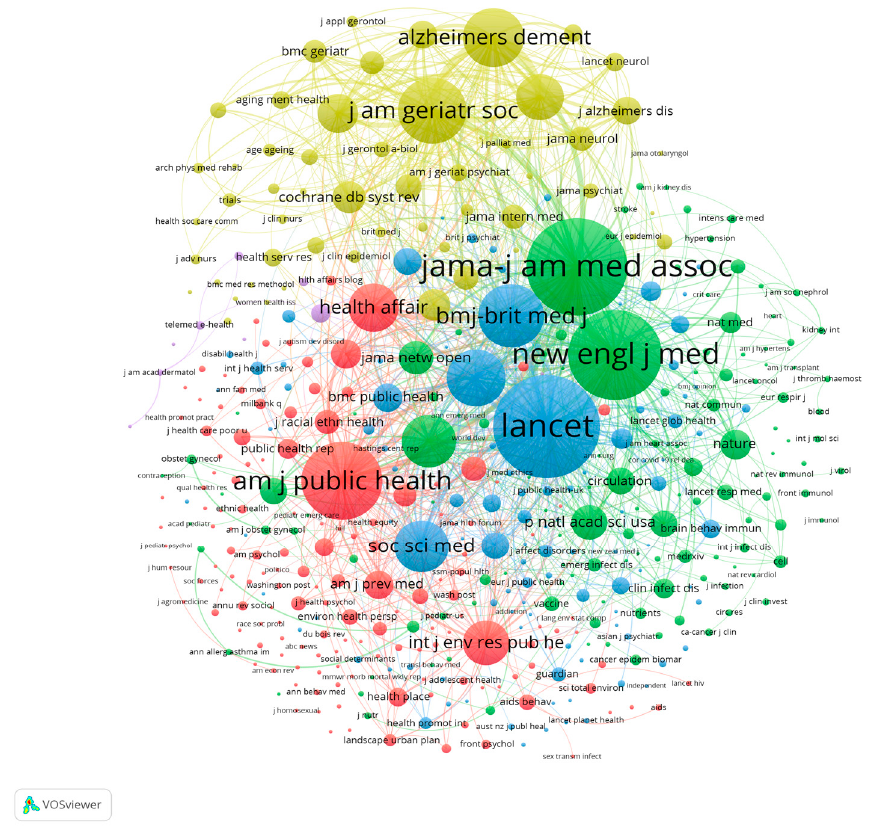
Figure 4. Co-citation network of journals (five clusters of 439 items). Note(s): Colors represent clusters, the thickness of linked lines represents the intensity of co-citation, and node sizes represent citation frequency.